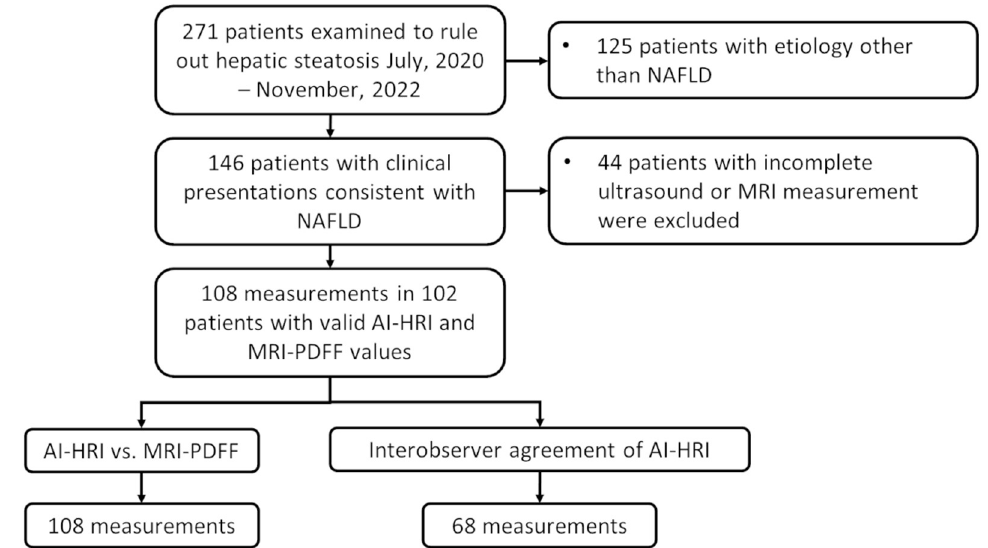
Figure 1. The flowchart demonstrates patient selection and study design. We prospectively enrolled 102 participants with suspected non-alcoholic fatty liver disease (NAFLD) in our study. Two hundred and seventy-one patients were referred to either an ultrasound or an MRI scan at our department to rule out hepatic steatosis; out of these, in 146 patients who did not show signs of acute liver failure, clinical findings were consistent with NAFLD. Forty-four patients who did not have a complete artificial intelligence-calculated hepatorenal index (AI-HRI) and magnetic resonance imaging proton density fat fraction (MRI-PDFF) measurements were excluded from the study. We evaluated the diagnostic accuracy of AI-HRI by comparing it to MRI-PDFF as a reference using 108 independent measurements of 102 patients. The interobserver agreement of AI-HRI was assessed in 68 cases, where measurements by two different examiners were available.